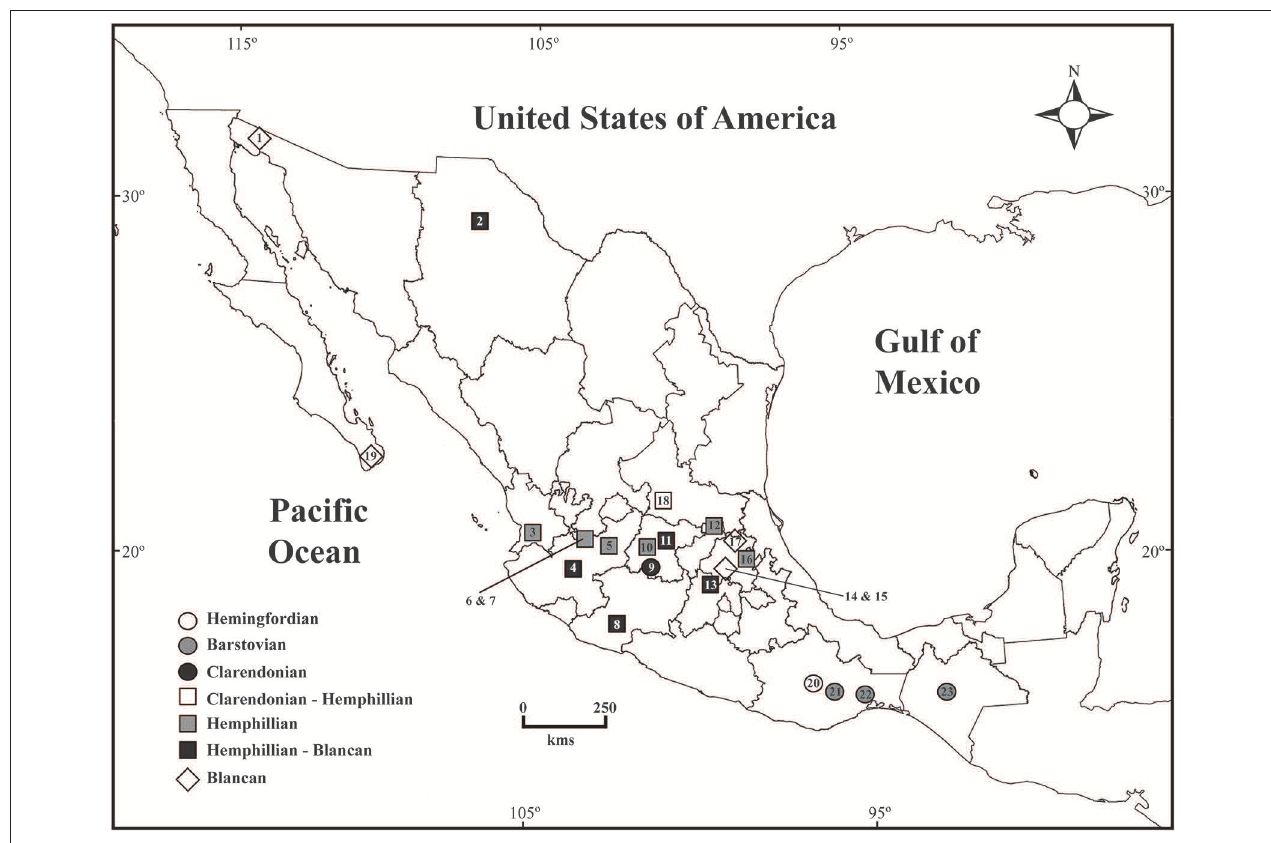
FIGURE 1 | Geographic distribution of Mexican Equinae throughout the Neogene. The list of localities as in Table 1